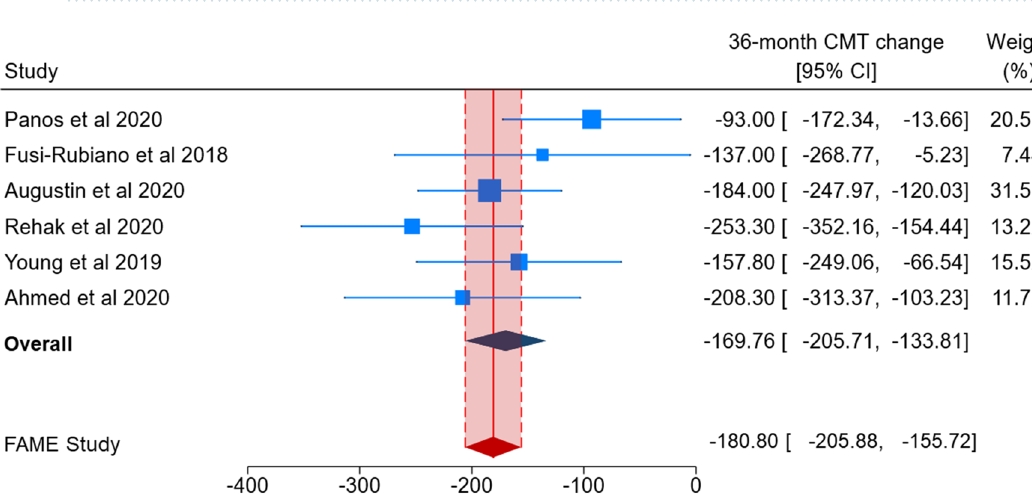
Figure 4. A forest plot showing 24-month central macular thickness (CMT) change, reported as Mean Difference (MD) with 95% confidence interval (CI), in real-world studies and 24-month foveal thickness change in the FAME study.